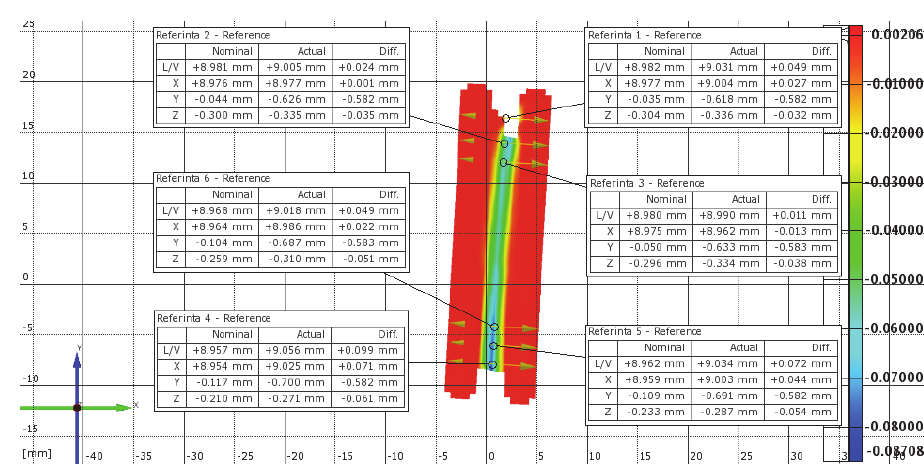
Figure 4: Shearing strain in the adhesive along the